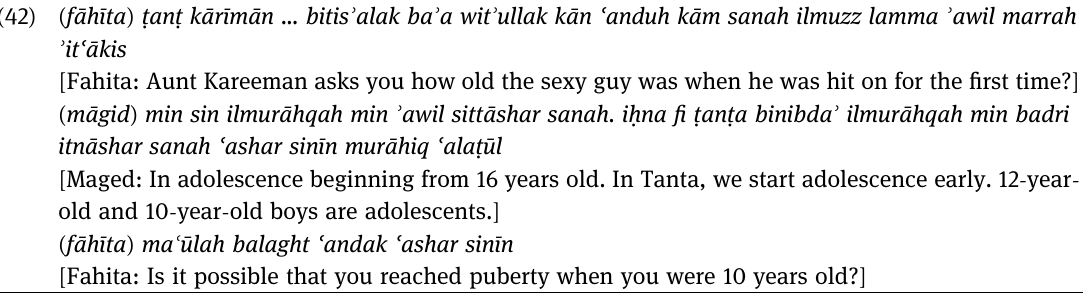
[ Fahita: There is a question from Bebesan, 27 years old and a convict in a contempt of religion case. She tells you that bigamy ( having a second wife ) is widespread. Would the sexy guy do it or is he satis fi ed with cheating? Now we know the answer, satis fi ed! Yes, satis fi ed. ] The next question in ( 42 ) also includes a reference to Maged as ilmuzz [ the sexy guy ] . The fan ’ s question seems innocent at fi rst. She asks about the age when Maged was fi rst hit on. Maged ’ s answer, that in his hometown, Tanta, adolescence starts early probably at the age of 10 or 12 years, leads Fahita to make a shocking remark about the young age Maged reached sexual puberty. This is a sensitive issue in Egypt and not normally acceptable to discuss.